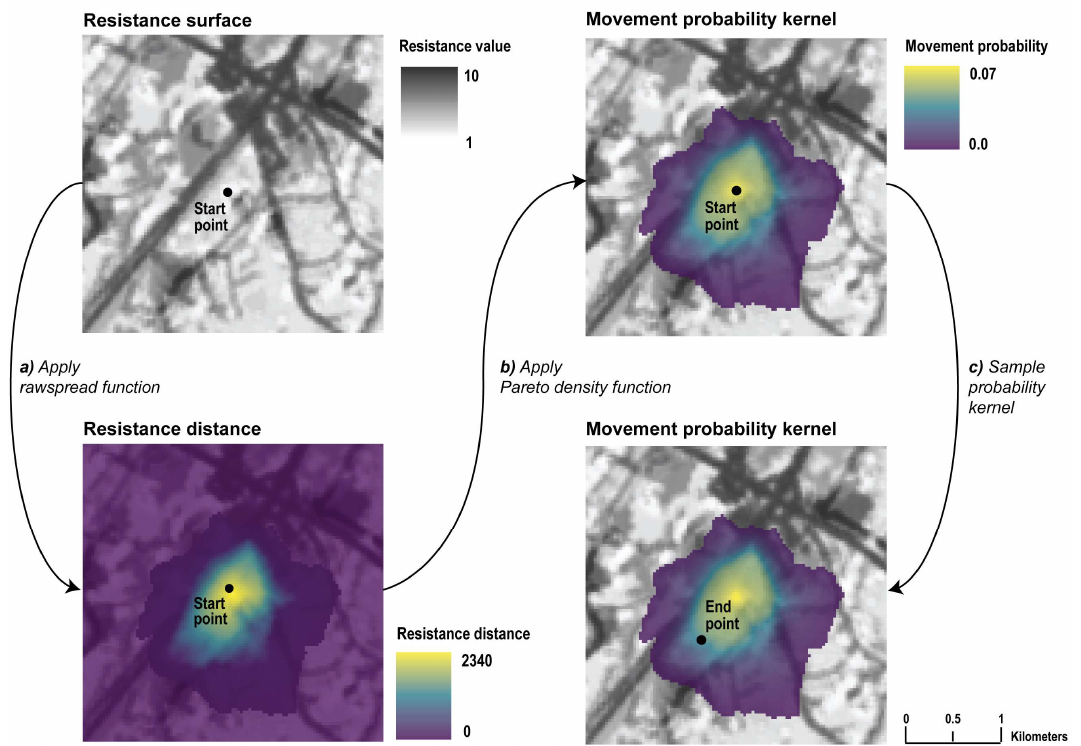
Figure 2. Procedure for simulating one step for the black bear individual-based movement models (IBMMs). From a start point on the resistance surface, ( a ) we applied and took the inverse of the rawspread function [40] which calculates resistance distance from the start point. We then ( b ) applied the Pareto density function of the appropriate diel period and season to the resistance distance surface to create a movement probability kernel and transformed the kernel to sum to 1. We then ( c ) probabilistically sampled a destination (end) point on the movement probability kernel.